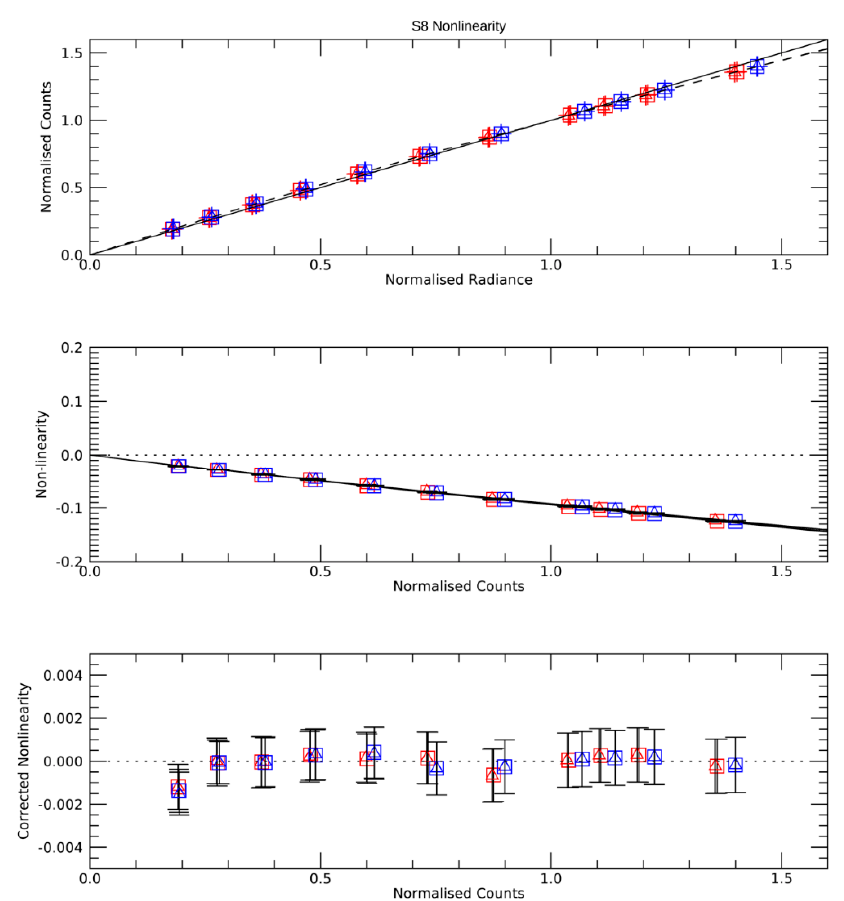
Figure 9. Determination and verification of response non-linearity for SLSTR-B 10.8 um channel. ☐ = Detector 1, Integrator 1; ☐ = Detector 1, Integrator 2; Δ = Detector 2, Integrator 1; Δ = Detector 2, Integrator 2.